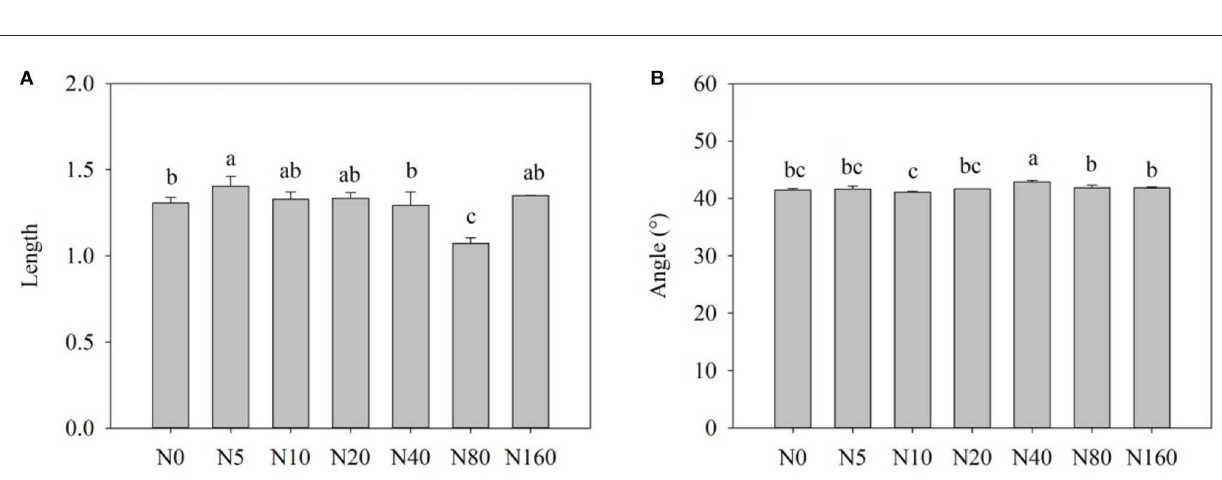
(Sinsabaugh et al., 2005). We here focused on the activities of